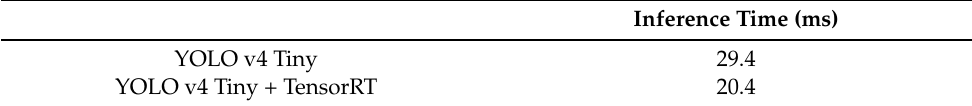
Table 2. Inference time between different object detector models.